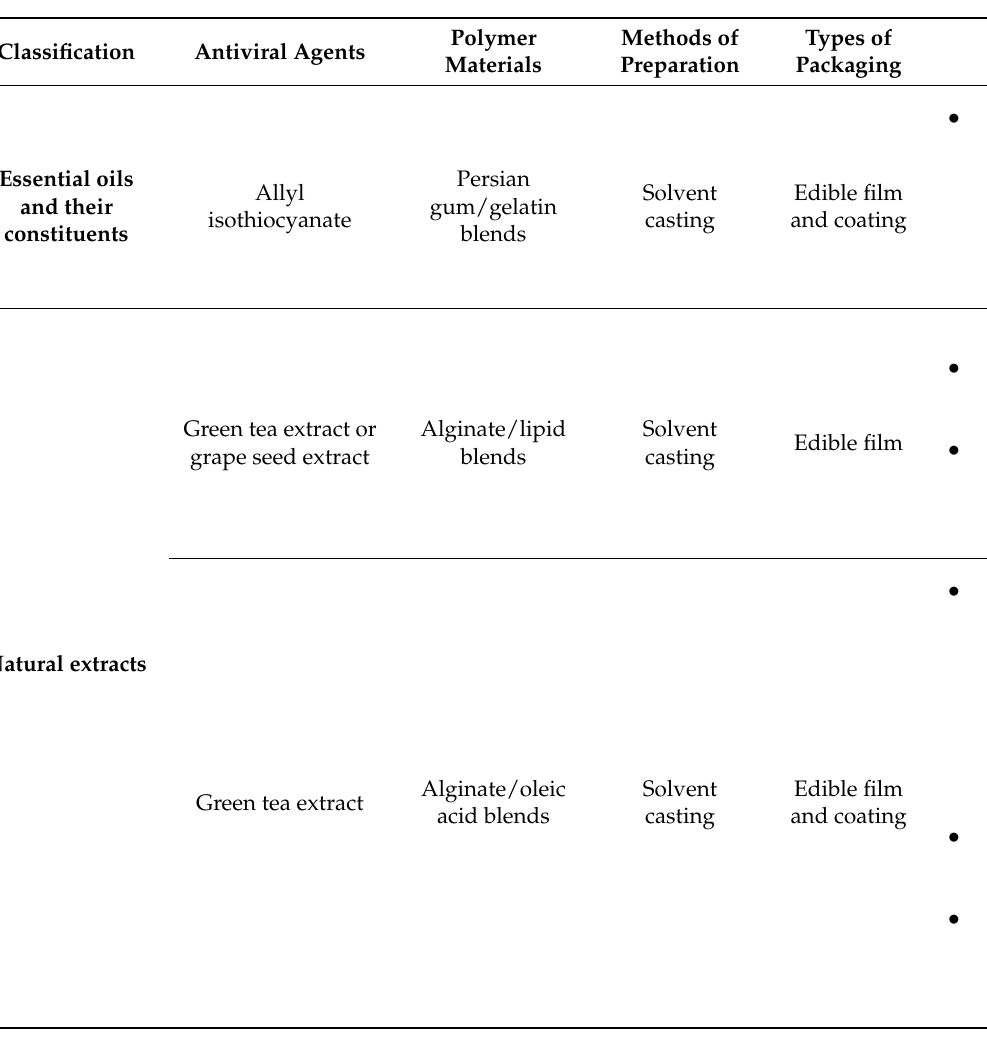
Table 3. Antiviral packaging applications used in food